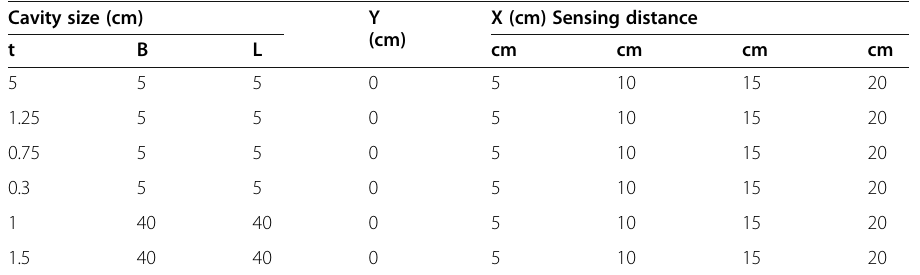
Table 3 Cavity size and sensing distance